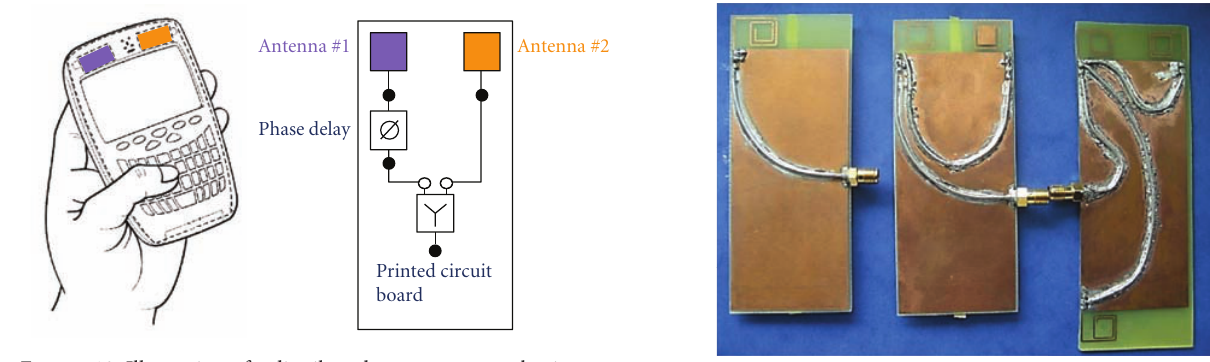
F 18: Illustration of a distributed antenna system having two elements placed at different locations of a handset